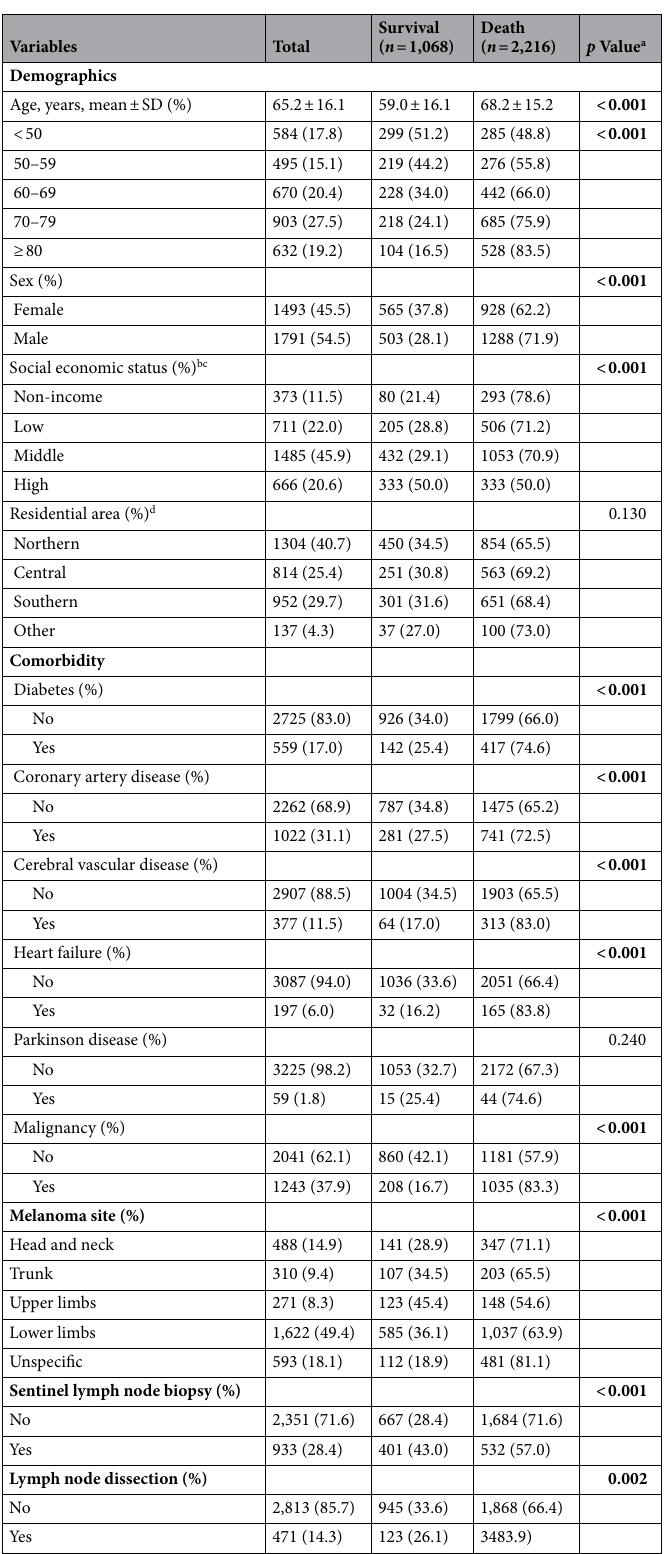
Table 1. Demographic characteristics, comorbidity and clinical characteristics of first-event melanoma patients in survival and death groups ( n = 3284). a Using Chi-square test. Bold type indicates statistical significantly ( P < 0.05). b Social economic status was classified as non-income (no income), low (income ranges from 1 to 583 US$ per month), middle (income ranges from 584 to 833 US$ per month) and high (income ≥ 834 US$ per month) categories. c 49 patients were unknown. d 77 patients were